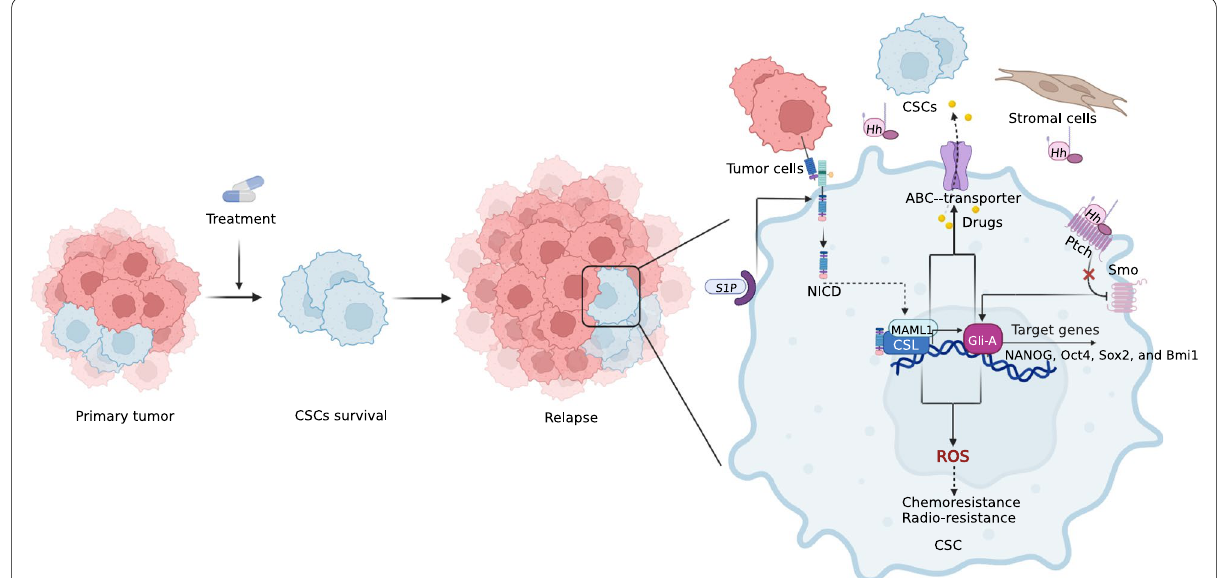
Fig. 2 Overview of the Notch and Hedgehog signaling pathways in CSCs. Peripheral tumor cells, CSCs, and mesenchymal cells can initiate the transcription of stemness genes (NANOG, Oct4, Sox2, and Bmi1) in CSCs through Hedgehog signaling to maintain stem cell properties. The role of the Notch and Hedgehog signaling pathways is demonstrated in the zoomed-in CSC on the right side of the figure. S1P enhances CSC activity by binding S1PR secondary to Notch activation. The Hedgehog and Notch pathways also increase ABC-transporters, which increases drug efflux and leads to chemoresistance. The Hedgehog and Notch pathways also increase ROS further affecting the efficacy of subsequent drug and radiation